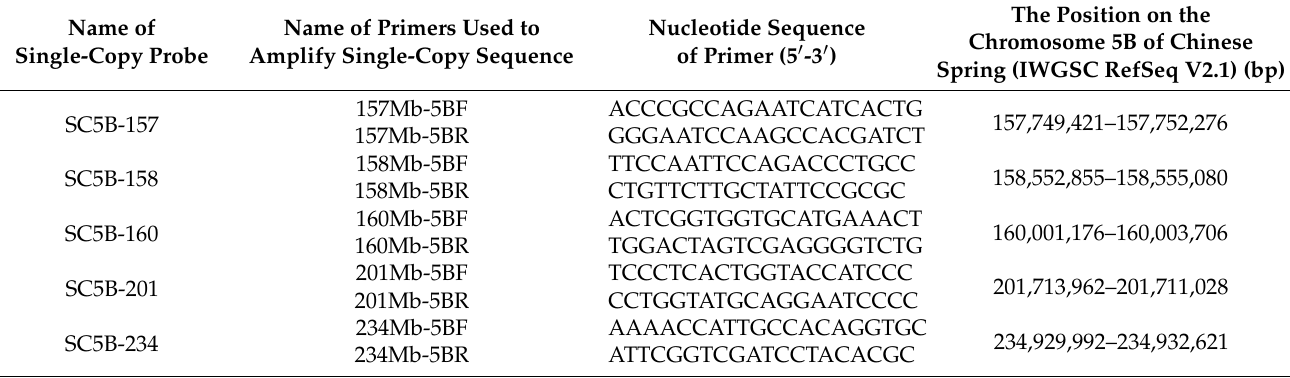
Table 1. The information of the single-copy probes used in this